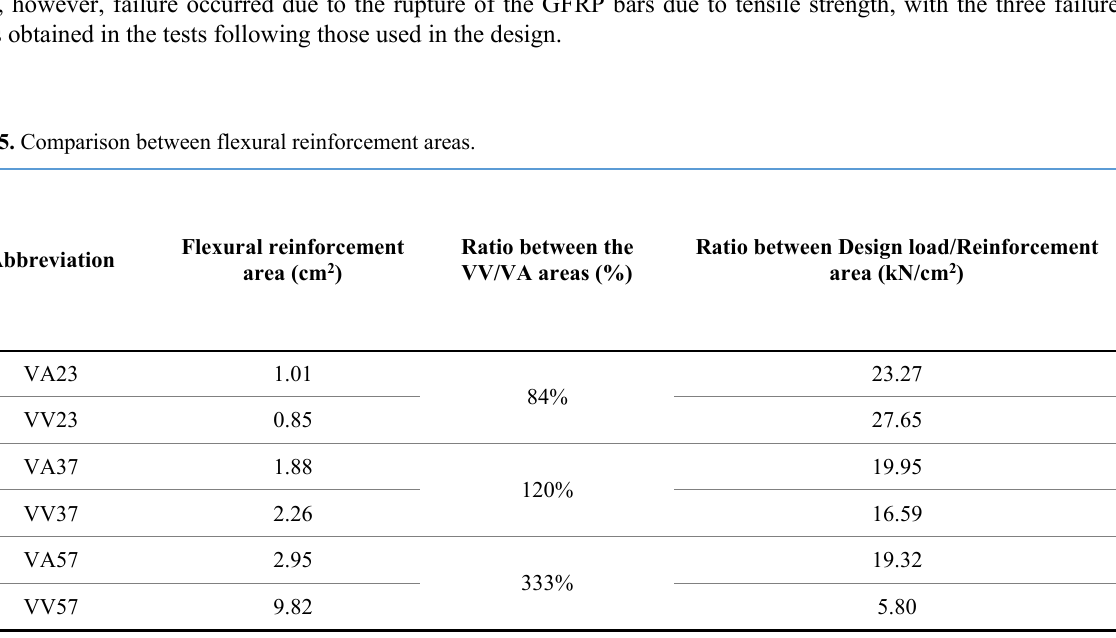
Table 5. Comparison between flexural reinforcement